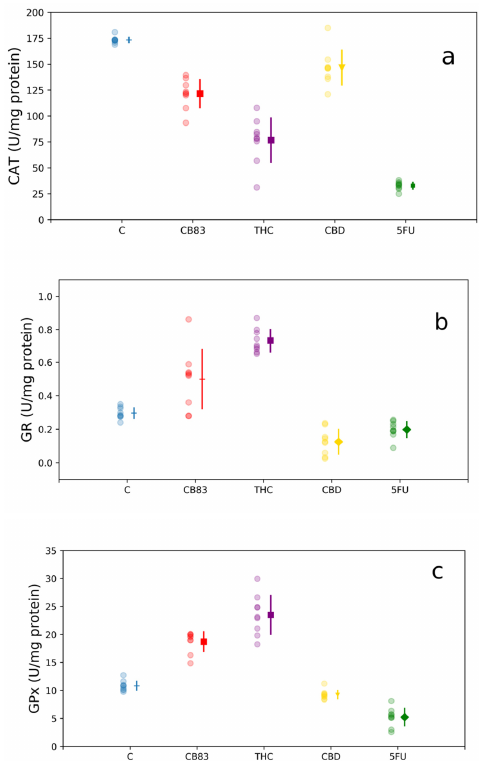
Figure 4. Antioxidant enzymes activity: ( a ) catalase (CAT), ( b ) glutathione reductase (GR), and ( c ) glutathione peroxidase (GPx) in HT-29 cells exposed to IC 50 of CB83, THC, CBD, and 5FU. Data are representative of three independent experiments. For each treatment, the experimental measurements (left side with circle marker) and mean values ± S.D. (right side) are reported. Mean value markers represent the significance vs. control (C): triangle for p < 0.05, diamond for p < 0.01, and square for p < 0.001; hyphen if dataset is not significant. Table 2. Results from screening with the Annexin V(AnV)-fluorescein isothiocyanate (FITC) and propidium iodide (PI) assay. Intact cells appeared unstained (AnV- or PI-), apoptotic cells with phosphatidylserine (PS) externalization were green stained with FITC-Annexin (AnV + PI-), and necrotic cells were red stained (AnV- PI + or AnV + PI + ) with the broken plasma membrane. Intact